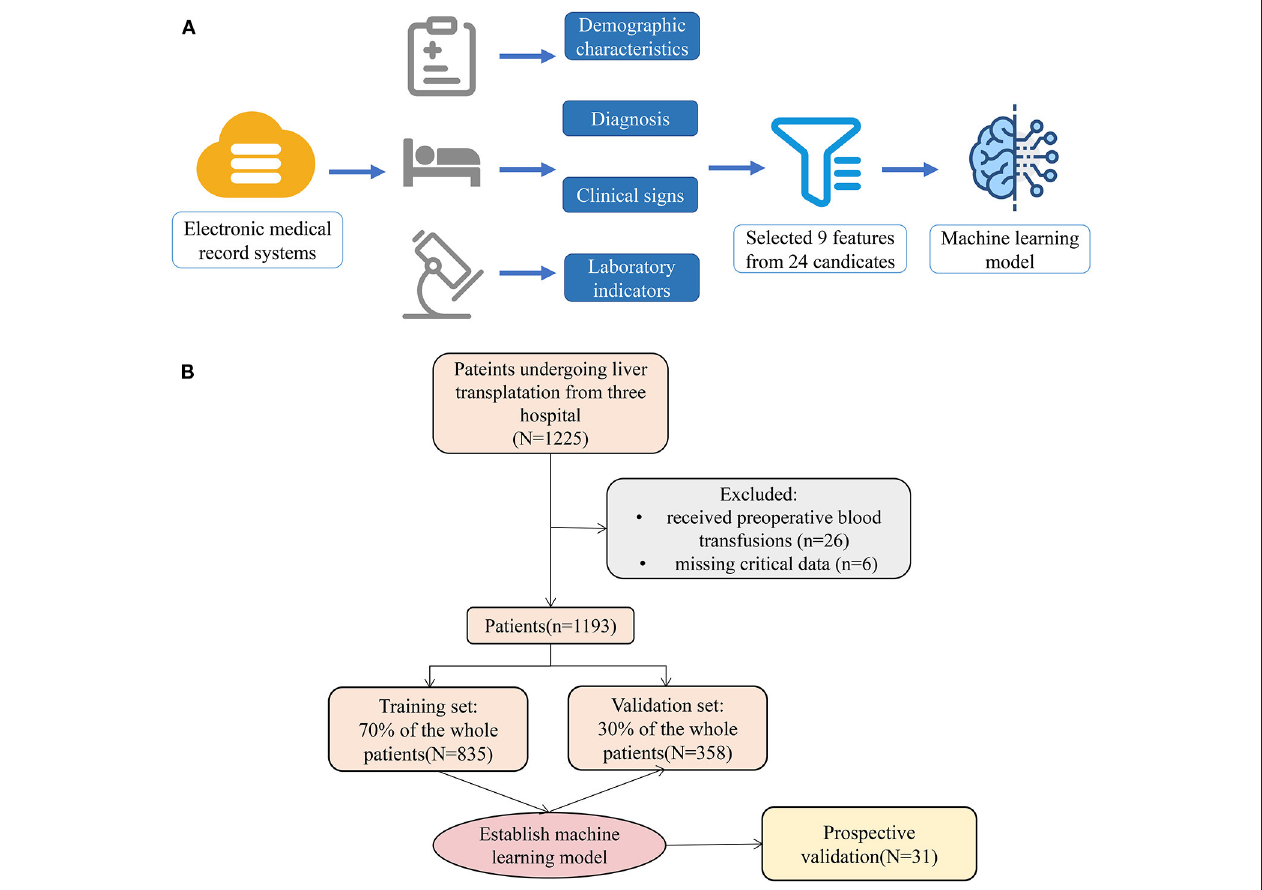
FIGURE 1 | Model-making process and flowchart of the study. (A) This figure demonstrated that the data were obtained from the electronic medical record systems of the three hospitals, and all variables included demographic characteristics, diagnosis, clinical signs, and laboratory indicators. A total of 24 preoperative variables were collected, and 9 variables were screened. Moreover, the study used the 9 variables to establish a machine learning model. (B) The flowchart of our